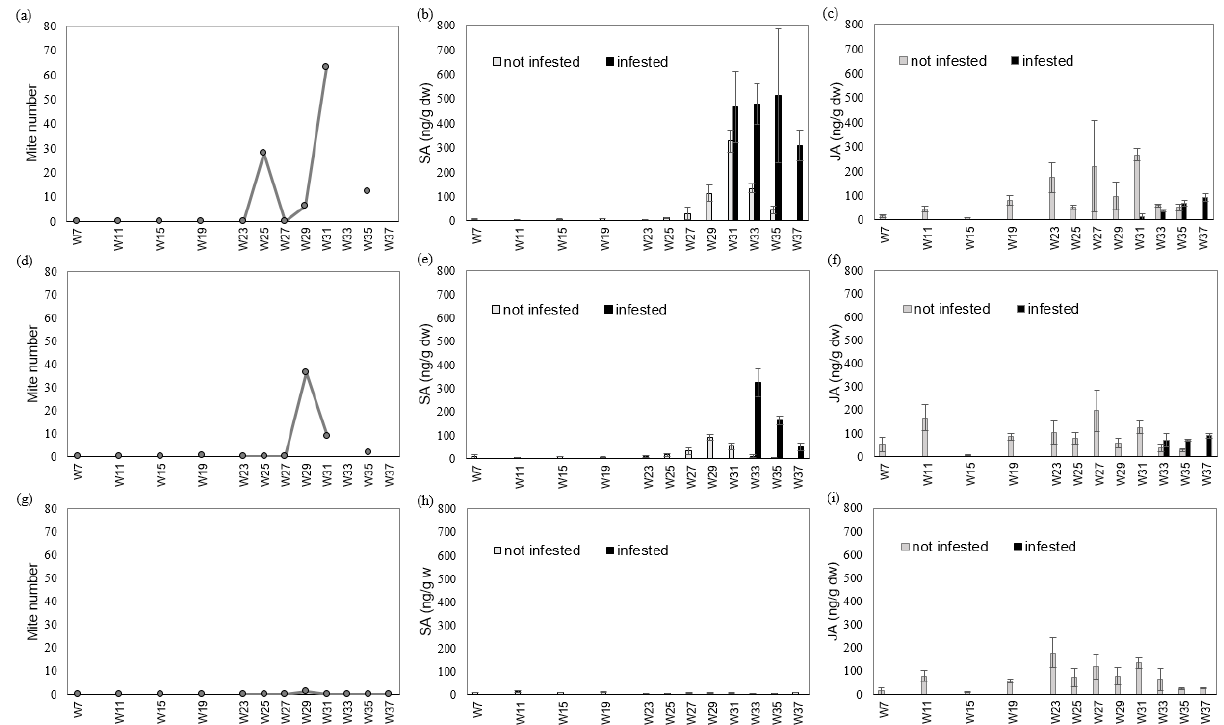
Figure 2. Experiment 2: Mean numbers of the mite Polyphagotarsonemus latus ( n = 3) counted on different sampling dates (12 time points) for ‘Nordlicht’ ( a ), ‘Mevrouw Gerard Kint’ ( d ) and ‘Elien’ ( g ), and respective levels of salicylic acid (SA) ( b , e , h ) and JA ( c , f , i ) (data are means ± SD) ( n = 3). In ‘Nordlicht’ (weeks 31, 33 and 35) and ‘Mevrouw Gerard Kint’ (weeks 33 and 35) samples were taken separately for plants showing symptoms and plants without symptoms ( n = 3).